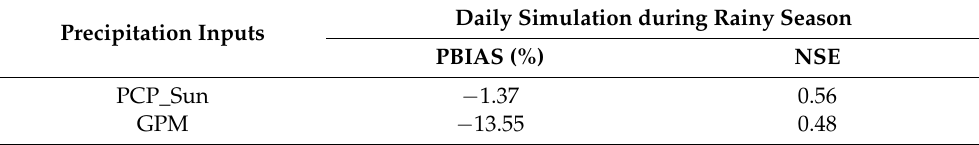
Table 8. Statistics for the streamflow simulation during rainy season at Nuxia hydrological station over 2001–2013.